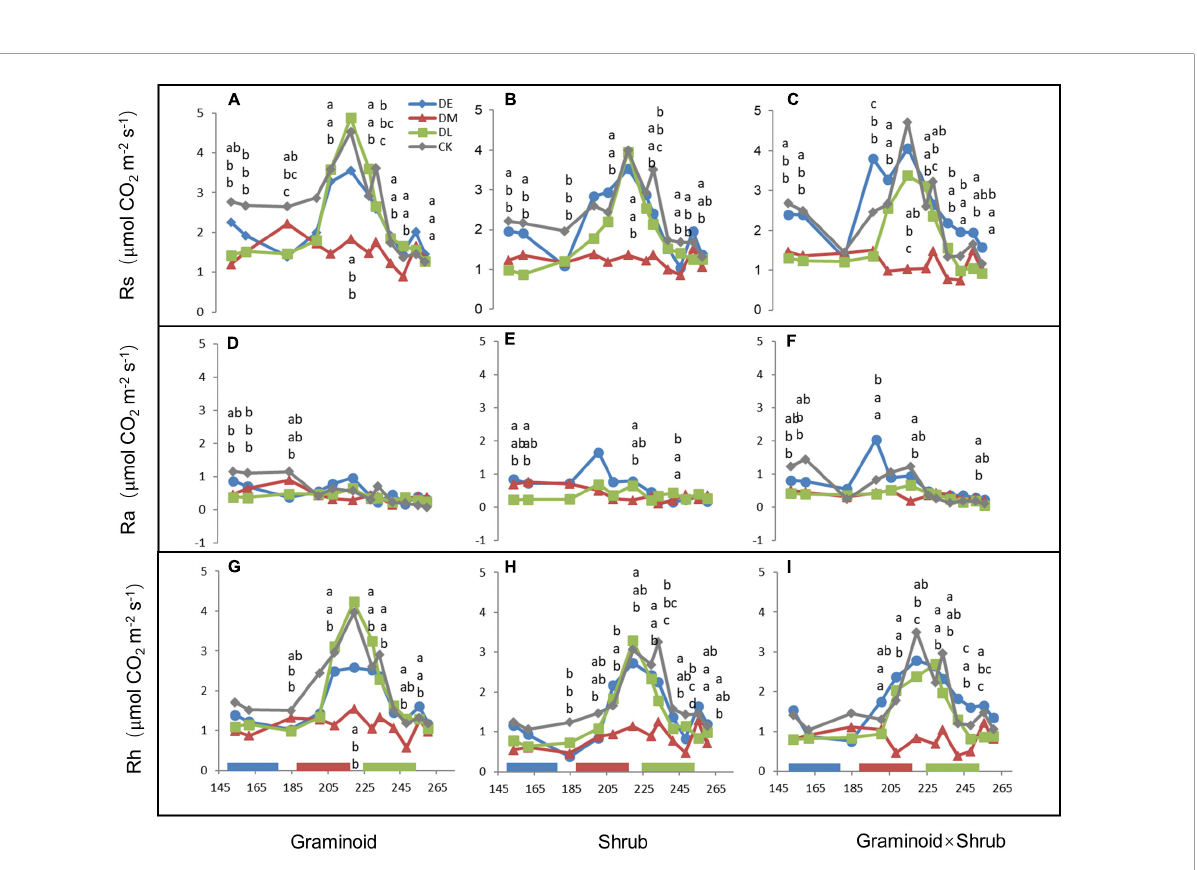
FIGURE4 Seasonal dynamics of Rs (A–C) , Ra (D–F) , and Rh (G–I) in 2017, corresponding to PFTs of G, S, and GS, respectively. Letters, arranged in the same vertical order as the points they refer to, indicated significant differences (a, identical to controls). For clarity, only significant differences were depicted. Data are mean ±